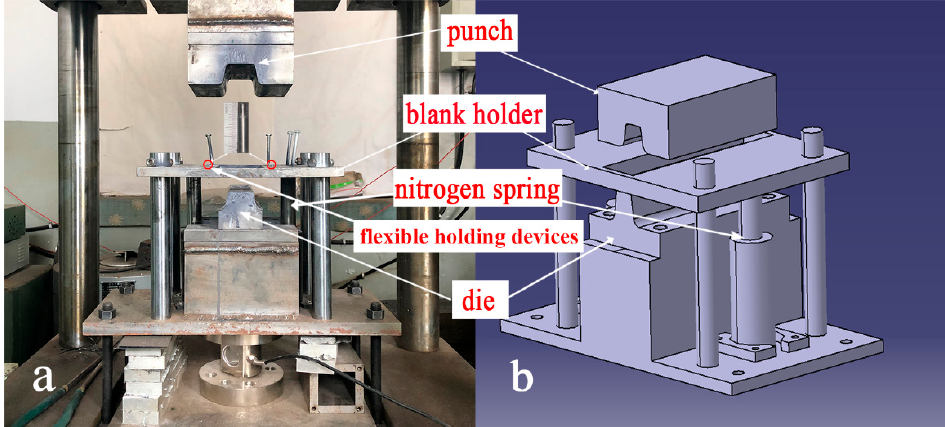
Figure 3. Set up of the U-shaped tools ( a ) Physical picture; ( b ) 3D model. U-shaped part hot stamping experiments were conducted with no lubricant, boron nitride lubricant (JD-3028), graphite lubricant (CRC-03094), and molybdenum disulfide lubricant (CRC-32660). The lubricant was sprayed on the surfaces of tools and the blank respectively, and the last remaining lubricant on the tools was cleaned with ethanol when the lubricant was changed each time.